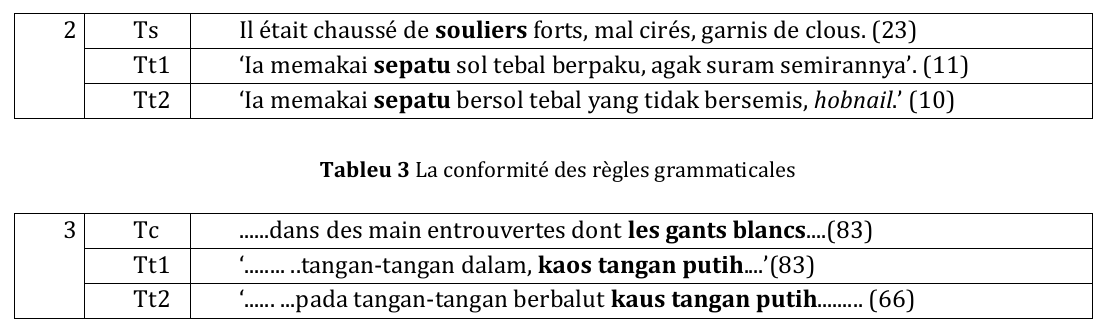
Tableu 2 La technique de transposition